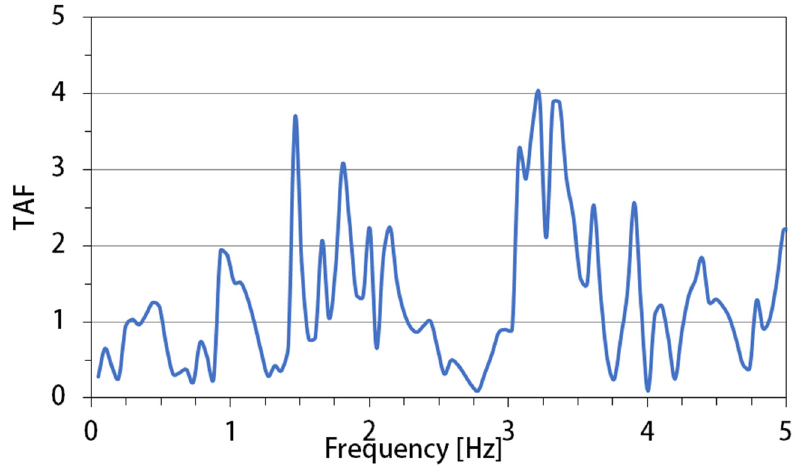
Figure 21. Topographic Aggravation Factor (TAF), after the Kallou et al. [48] approach, obtained as the ratio of the Fourier amplitude spectra at the crest and behind the crest, for the Amoruso et al. [26] input. The topographic amplification can be also evaluated in the time domain following the approach proposed by Bouckovalas and Kouretzis [49] in terms of the (2-D)/(l-D) ratio of elastic response spectra obtained at the crest. Figure 22 shows the Topographic Aggravation Factor (TAF) after the Bouckovalas and Kouretzis [49] approach for the Amoruso et al. [26] input. In this case, results show high values of TAF, reaching on average about 1.42 for the period range T of 0.20 to 1.0 s. Obtained values are in agreement with large amplifications obtained for similar studies performed on ridges, slopes and